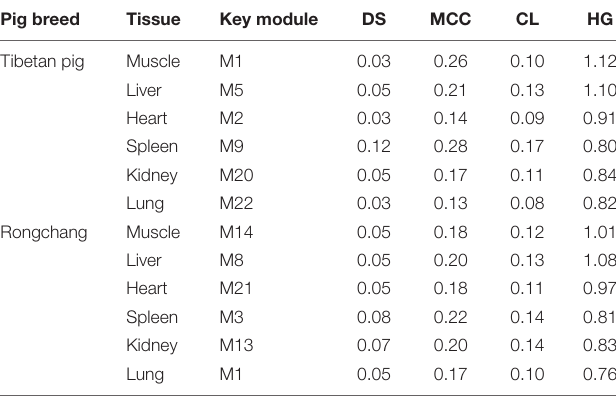
TABLE 1 | The fundamental network topology concepts of key modules in Tibetan pig and Rongchang pig tissues. Pig breed Tissue